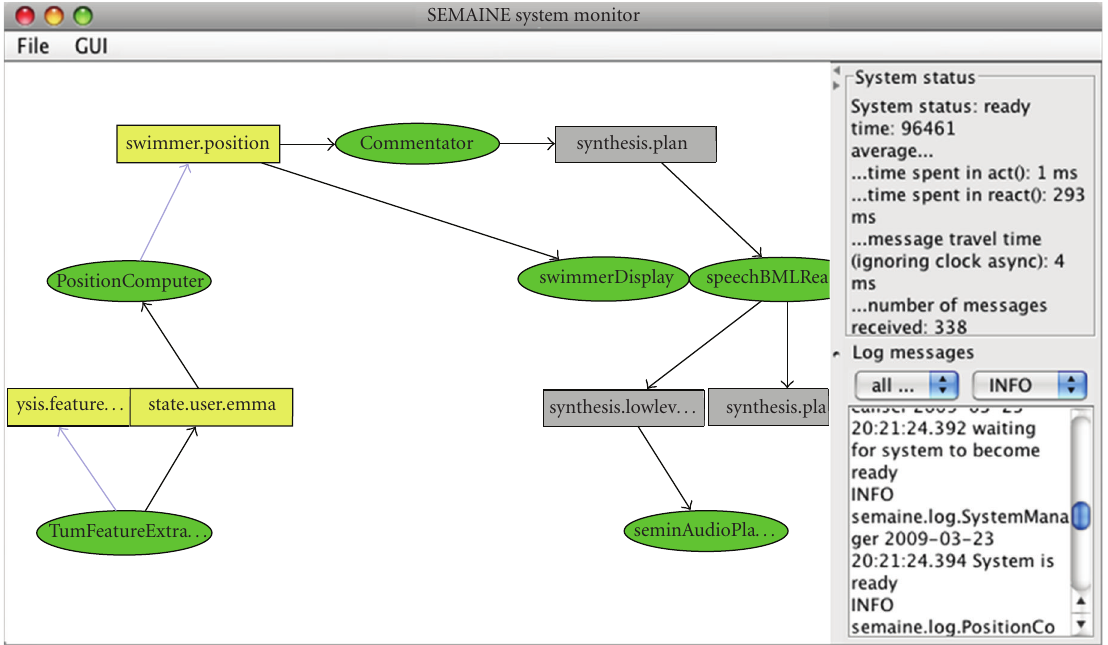
Figure 23: Message flow graph of the swimmer’s game